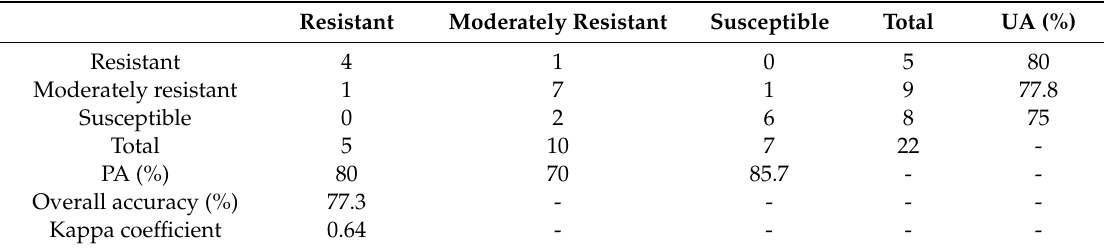
Table 3. Classification accuracies using optimized variables (all seven selected variables were at vegetative stage). PA and UA are producer’s and user’s accuracy, respectively. Resistant Moderately